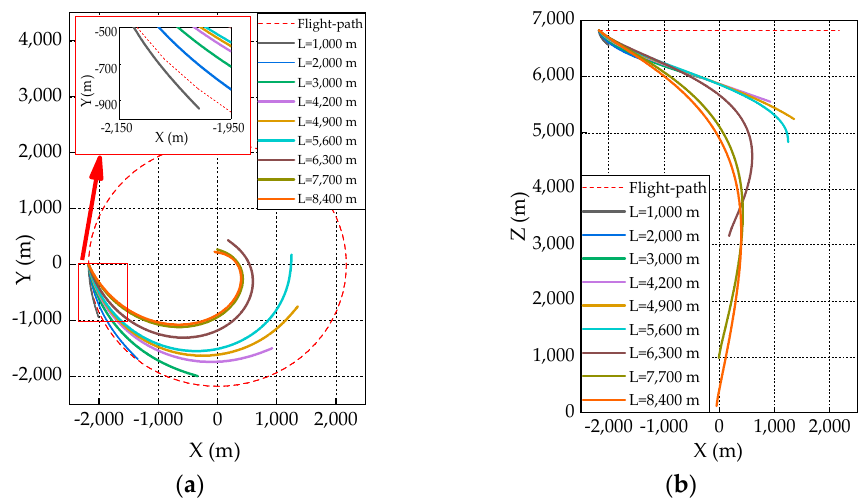
Figure 12. Towline spatial configurations vs. towline length: ( a ) Two-dimensional projection in horizontal plane. ( b ) Two-dimensional projection in vertical plane.